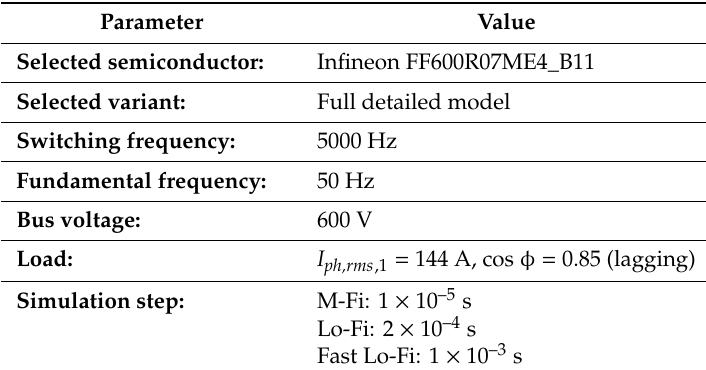
Table 2. A comparison of the operating point data for the electrical models.